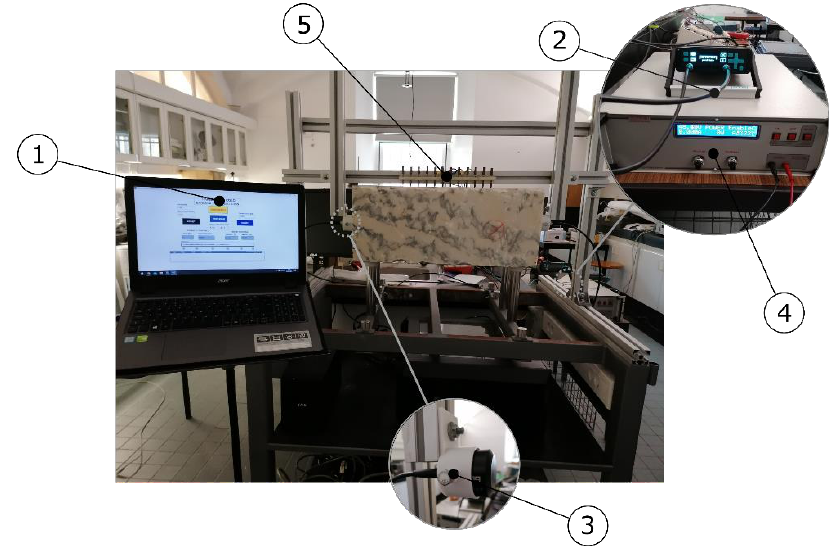
Figure 11. Laboratorial setup — measurement hardware. 1-SCADA PC-server; 2-Proceq Pundit Lab+; 3-Ultrasonic Transducer; 4-EUTRON Power Supply; 5-Electrodes.